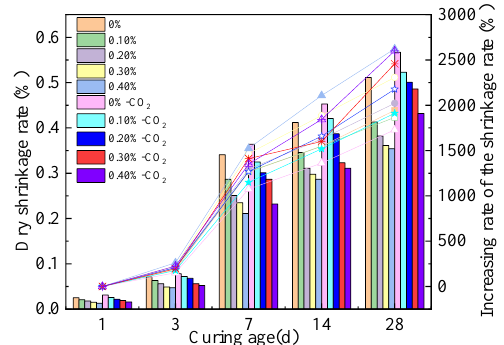
Figure 6. The D-S rate of the MOS paste.